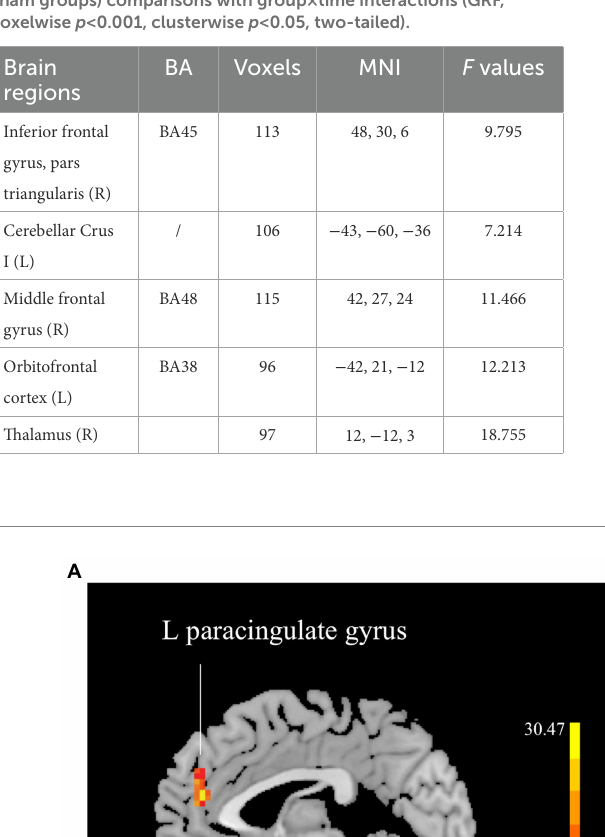
TABLE 3 Brain regions with significantly different values of fALFF in the intragroup (pre-and post-treatment) and intergroup (cTBS and